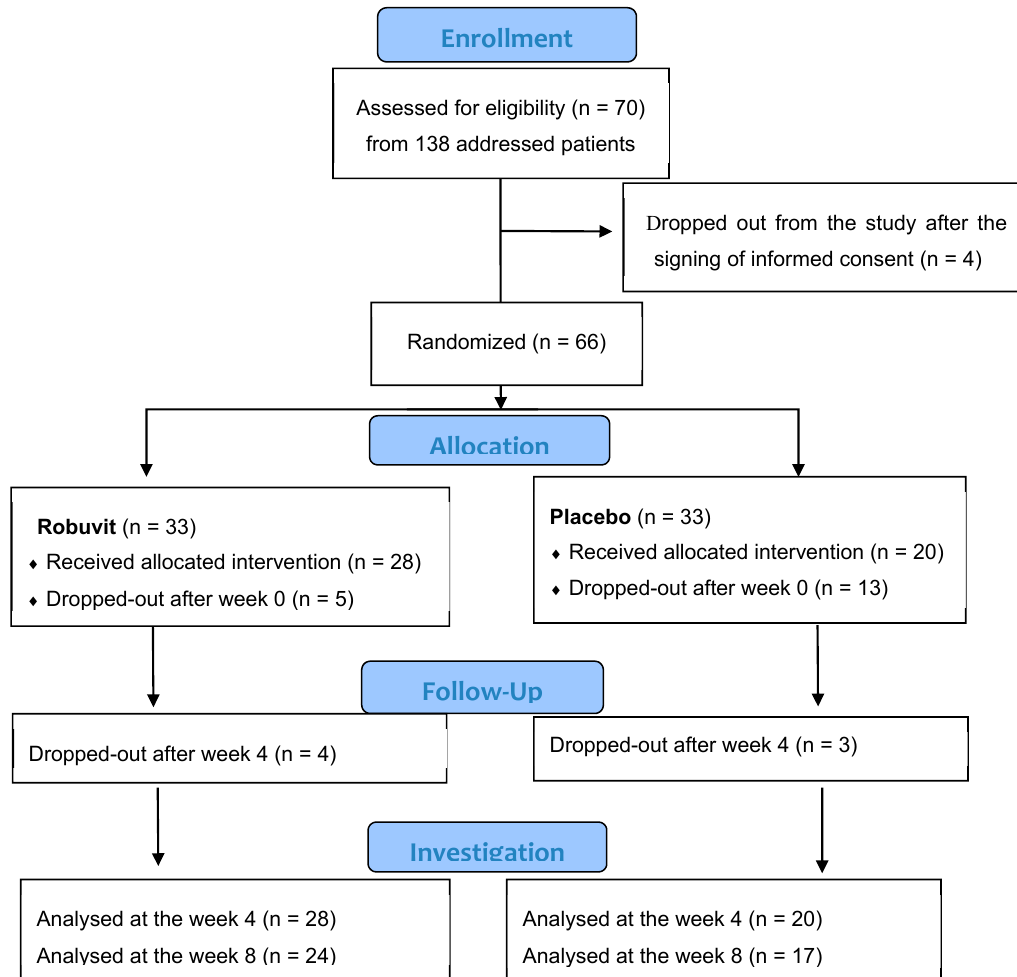
Figure 2. CONSORT (Consolidated Standards of Reporting Trials) flow diagram of the study.